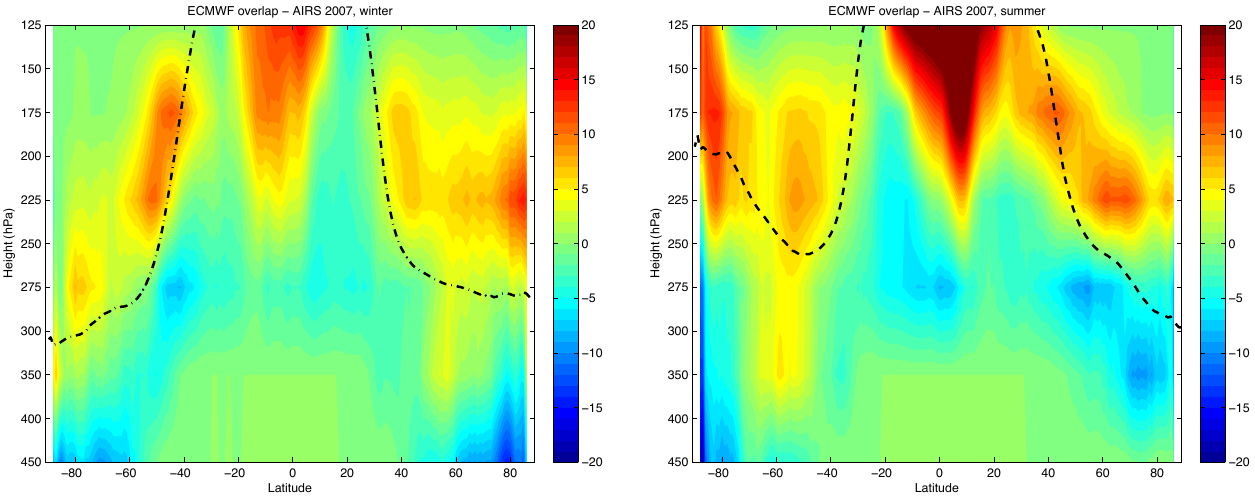
Fig. 18. Zonal means of ice supersaturation occurrence differences between ECMWF (“layer supersaturation” scheme) and AIRS for the 2007 boreal winter (left) and summer (right). Dashed line: zonal mean summer tropopause. Pointed dashed line: zonal mean winter